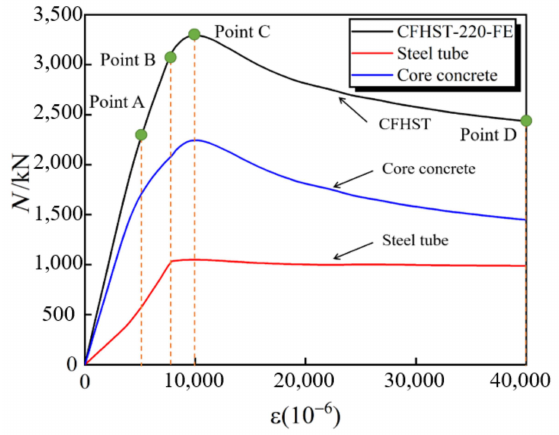
Figure 11. N- ε curve.